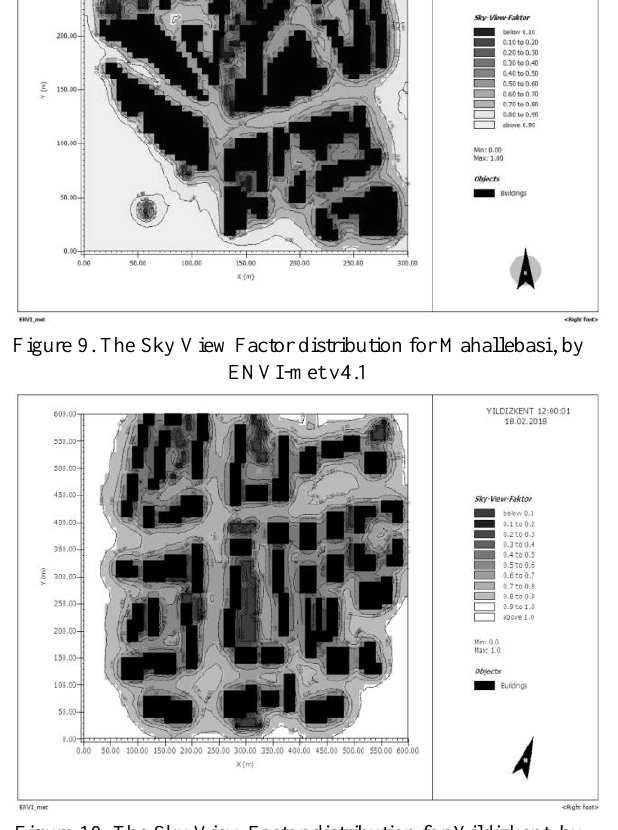
Figure 10. The Sky View Factor distribution for Yildizkent, by ENVI-met v4.1